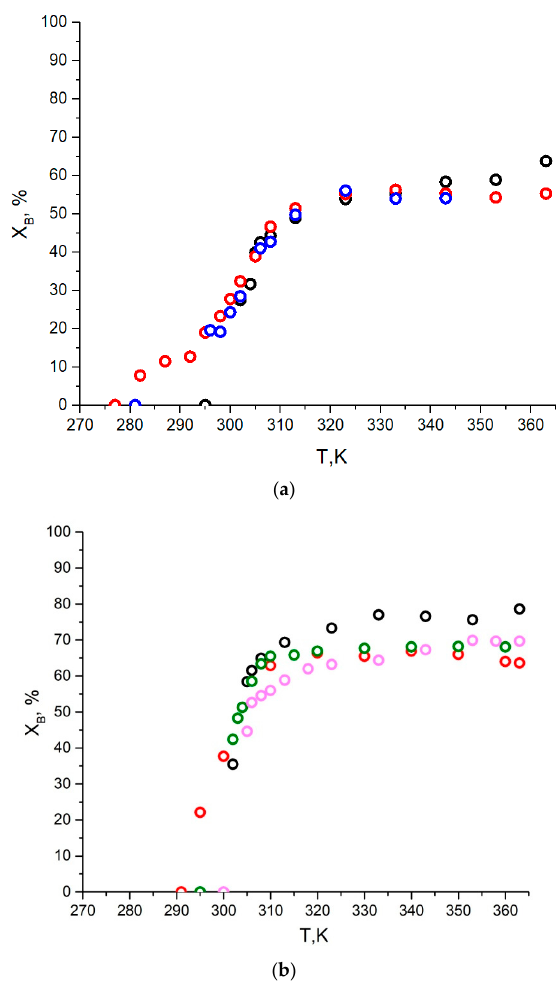
Figure 6. Temperature dependence of probe quantity in globules (X B ) measured as a result of EPR spectra modeling ( a ) for 5 wt% solutions, ( b ) for 10 wt% solutions. ( I —magenta, II —green, III —black, IV —red dots, V —blue dots). The data for homopolymer II was taken from